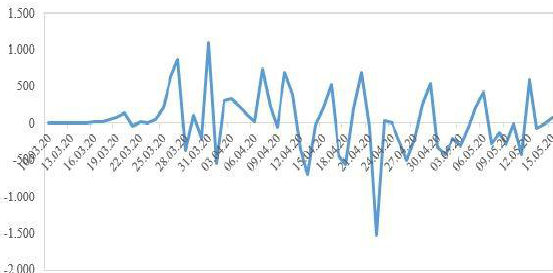
Fig. 2. Daily infected population difference in